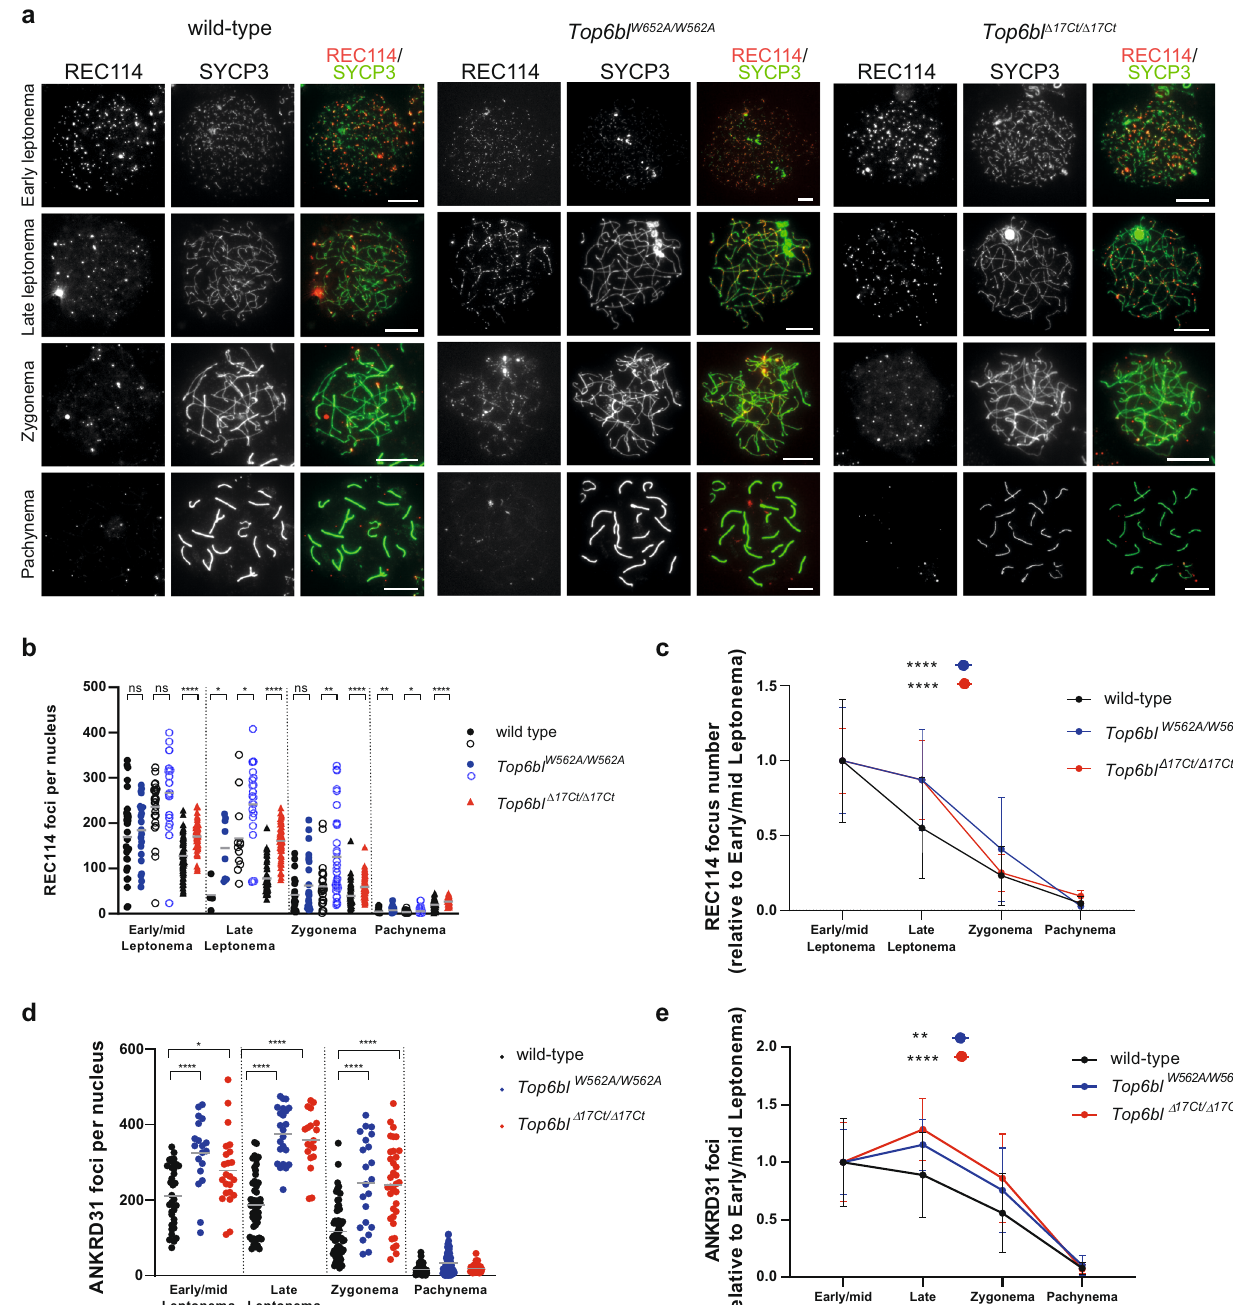
Fig.5|Ef fi cientREC114andANKRD31loadingin Top6bl mutantspermatocytes. a Immunostaining of REC114and SYCP3 in spermatocytes from 12-14dppwild-type (+/+), Top6bl W562A/W562A , and Top6bl Δ 17Ct/ Δ 17Ct mice. Scale bar, 10 μ m. b Quanti fi cation of axis-associated REC114 foci in early/mid and late leptotene, zygotene and pachytene spermatocytes from 12-14dpp wild-type (+/+ or Top6bl +/ Δ 17Ct : n =4), Top6bl W562A/W562A ( n =2), and Top6bl Δ 17Ct/ Δ 17Ct ( n =2) mice. Each mutant is compared with a wild-type control in parallel to control for variations between experiments. Resultsfrom Top6bl W562A/W562A arefromtwoindependentexperiments(labelledwith fi lled and open circles respectively). Number of nuclei: wild-type: 31 early/mid L, 4 late L, 26 Z, 51P; Top6bl W562A/W562A : 22 early/mid L, 8 late L, 26 Z, 24P; wild-type 28 early/mid L,12lateL,24Z, 46P; Top6bl W562A/W562A 18early/midL, 21 late L, 32Z,38P; wild-type:84early/midL,59lateL,84Z,75P; Top6bl Δ 17Ct/ Δ 17Ct :76early/midL,68late L, 79 Z, 61P. Grey bars show the mean values. P values were determined using the two-tailedunpairedMann-Whitneytest. c VariationofREC114fociduringprophase. The number of foci at early/mid leptonema, late leptonema, zygonema and pachynema (dataset as in panel b) relative to the mean number at early/mid